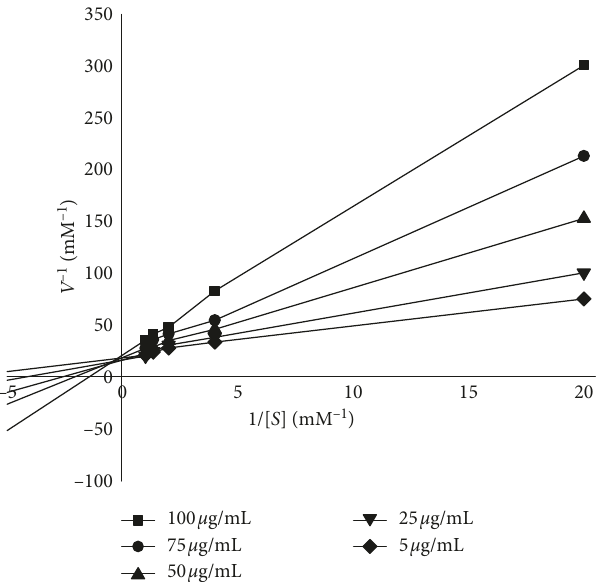
Figure 4: Lineweaver–Burk plots: inhibition of xanthine oxidase by S. mukorossi saponins with xanthine as the